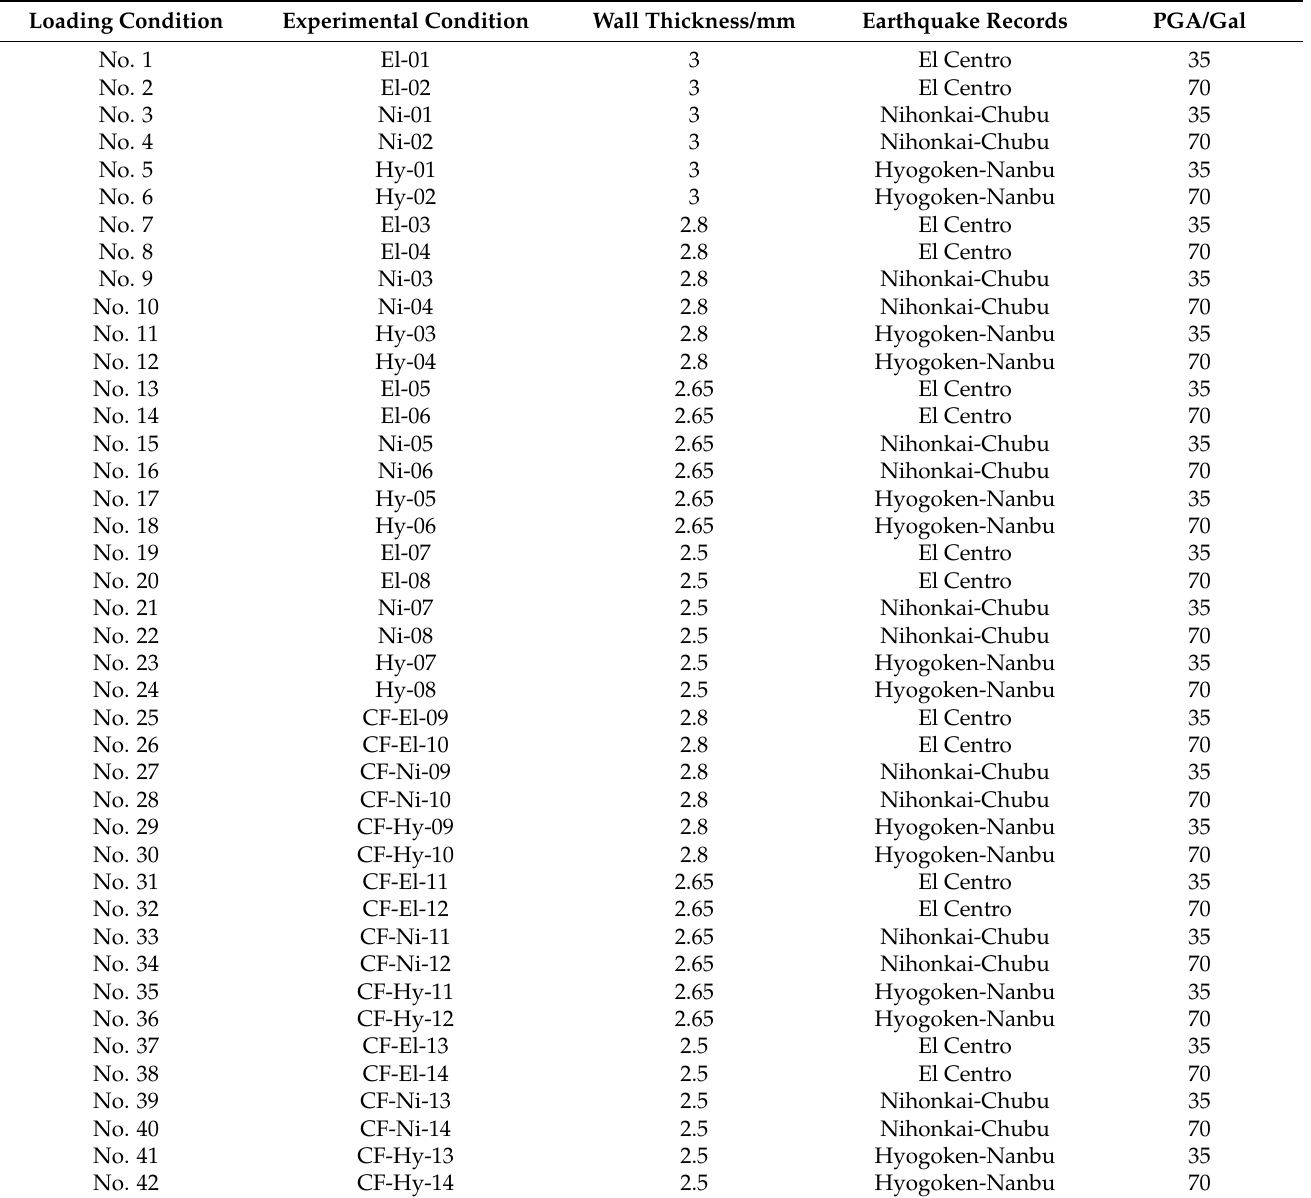
Table 8. Loading condition of shaking table